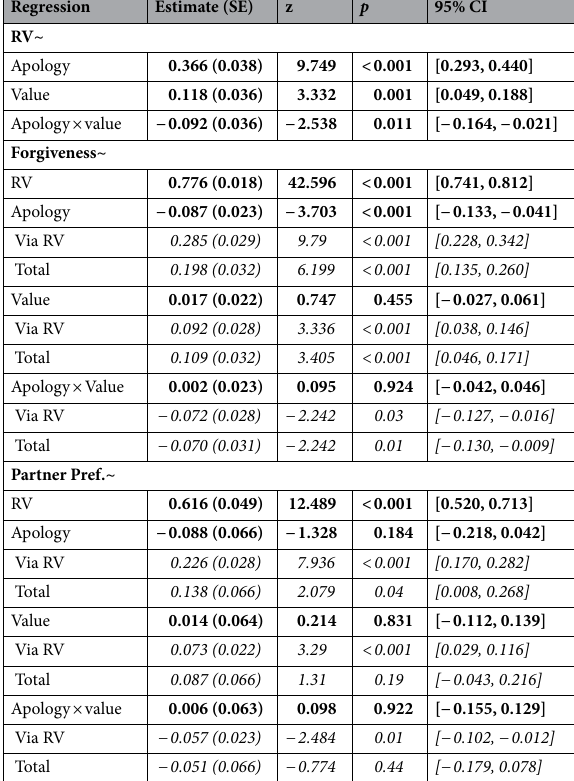
Table 2. Path coefficients for the direct and indirect effects in the main model. Coefficients are unstandardized, with coefficients pertaining to partner preference reported in log-odds. Confidence intervals were estimated using 1000 bootstrap samples. To distinguish direct effects from indirect and total effects, model direct effects are in bold while model indirect and total effects are